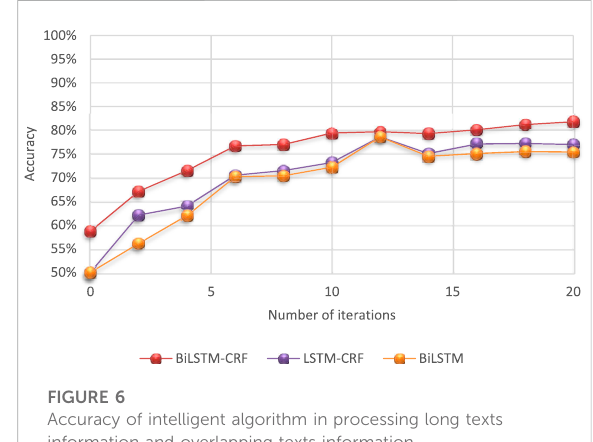
FIGURE 6 Accuracy of intelligent algorithm in processing long texts information and overlapping texts